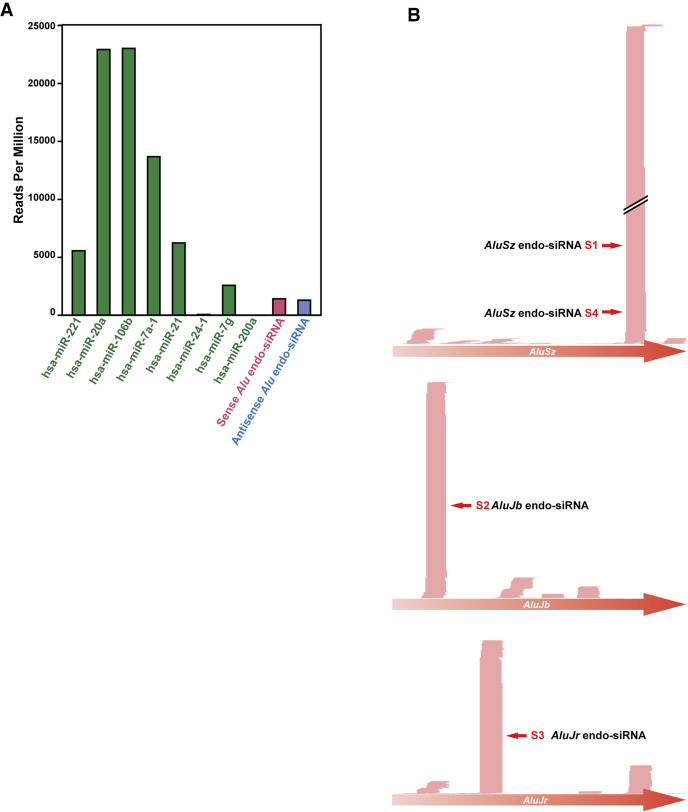
Alu siRNAs are loaded onto AGO2. (A) The read counts per million reads of various mature miRNAs and Alu siRNAs in small RNAs immunoprecipitated with AGO2 antibodies (GSM1334330). (B) Distribution of AGO2-bound Alu siRNAs corresponding to sense strands of AluSz (chr2:5532106–5532415), AluJb (chr1:236404589–236404810), and AluJr (chr1:227459304–227459613).